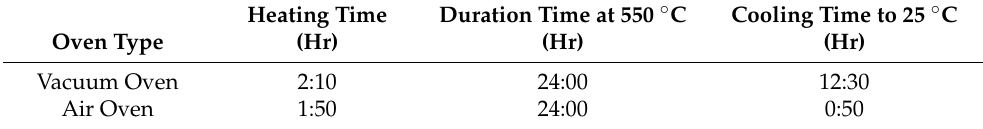
Table A1. Heat treatment